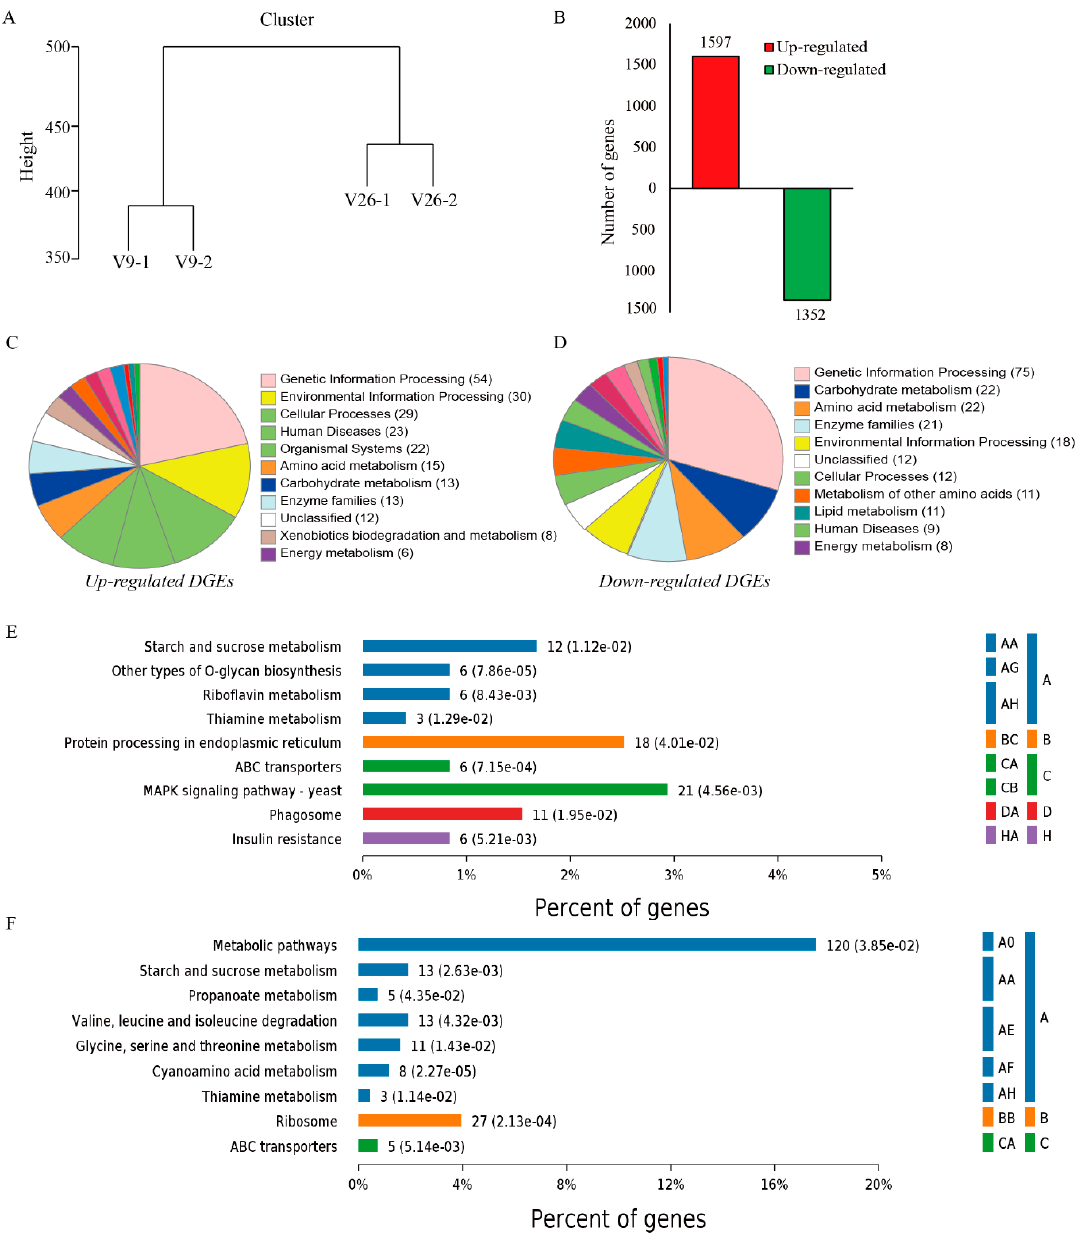
Figure 3. The analysis of gene expression. ( A ) The expression patterns from all samples were clustered. ( B ) The number of up/down-regulated DEGs were showed when v9 compared with v26. ( C ) The functional categories of the KEGG pathway enriched by up-regulated DEGs are showed. ( D ) The functional categories of the KEGG pathway enriched by down-regulated DEGs are displayed. ( E ) The pathways were significantly enriched by up-regulated DEGs ( P (adj.) < 0.05). ( F ) The pathways were significantly enriched by down-regulated DEGs ( P (adj.) < 0.05). A : Metabolism, B : Genetic